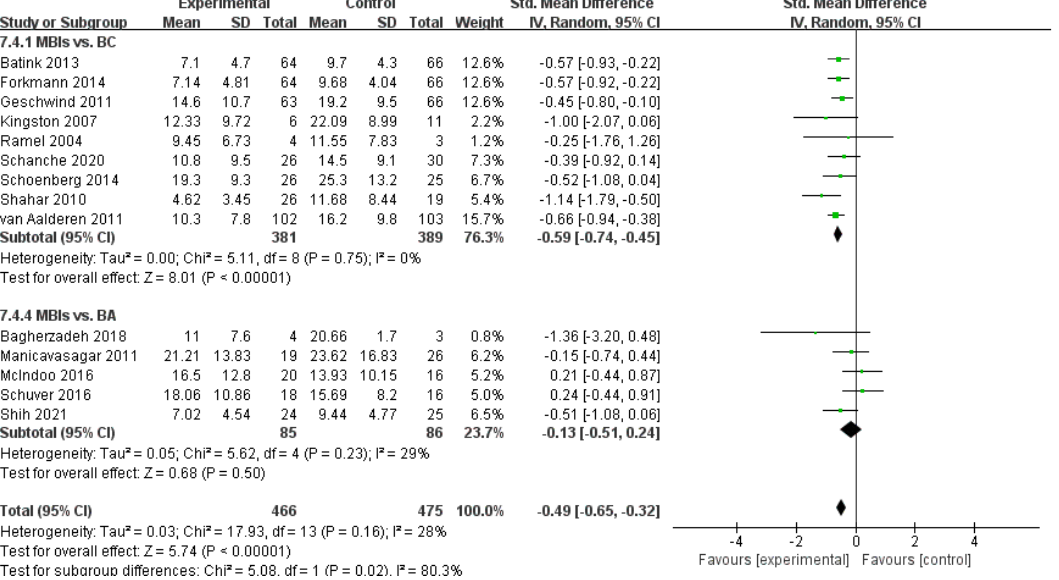
Figure 7. Meta − analyses of the effects of MBIs on depression between interventions of the control groups [32,33,35,36,39–48].